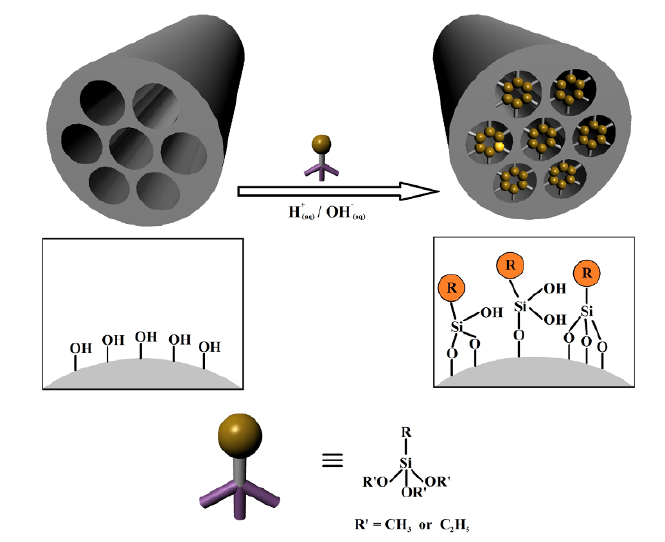
Figure 1. Scheme shows grafting as one of the methods for the modification of mesoporous